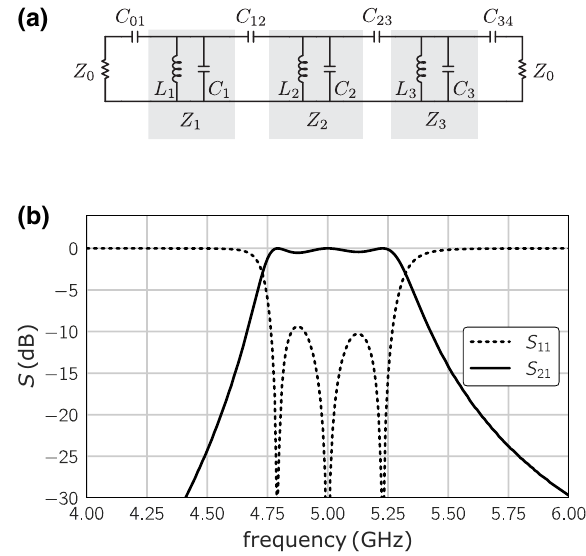
FIG. 12. Three-pole filter design example. (a) Circuit schematic, (b) S -parameter simulation in Keysight